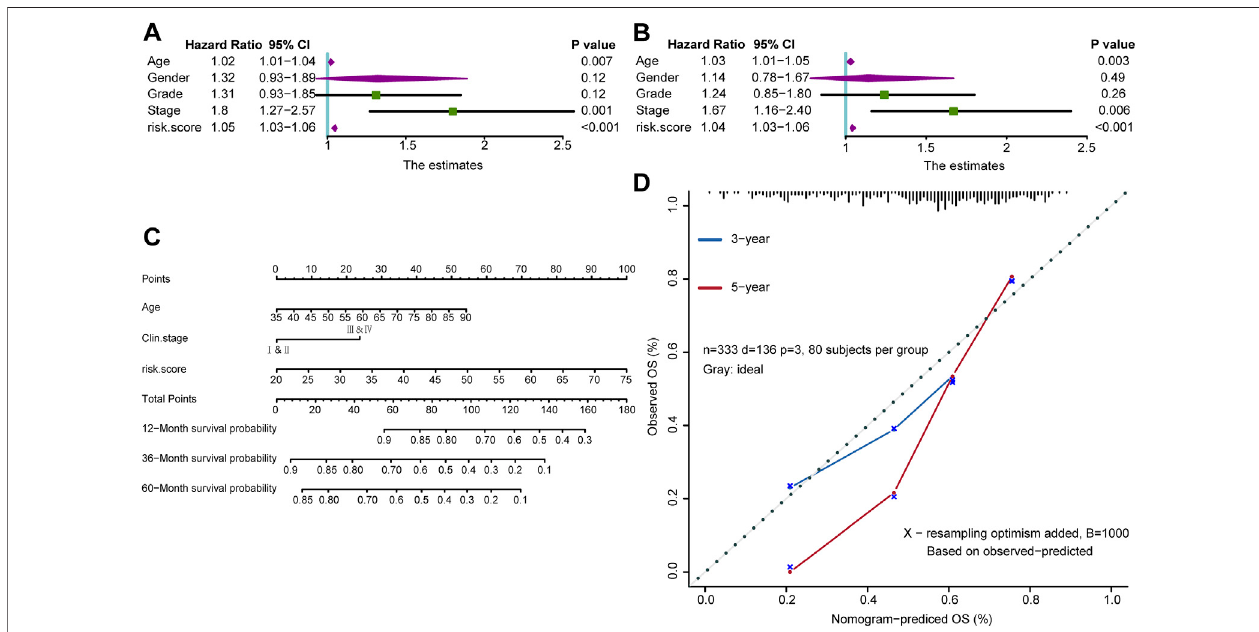
FIGURE 4 | A nomogram in the TCGA-STAD cohort combined with risk score and clinicopathological characteristics. (A,B) Univariate and multivariate Cox analyses of the risk score and clinicopathological characteristics. (C) The survival outcomes at 12-month, 36-month, and 60-month were predicted using the nomogram. (D) Calibration curves of the nomogram were conducted using the Hosmer-Lemeshow test.